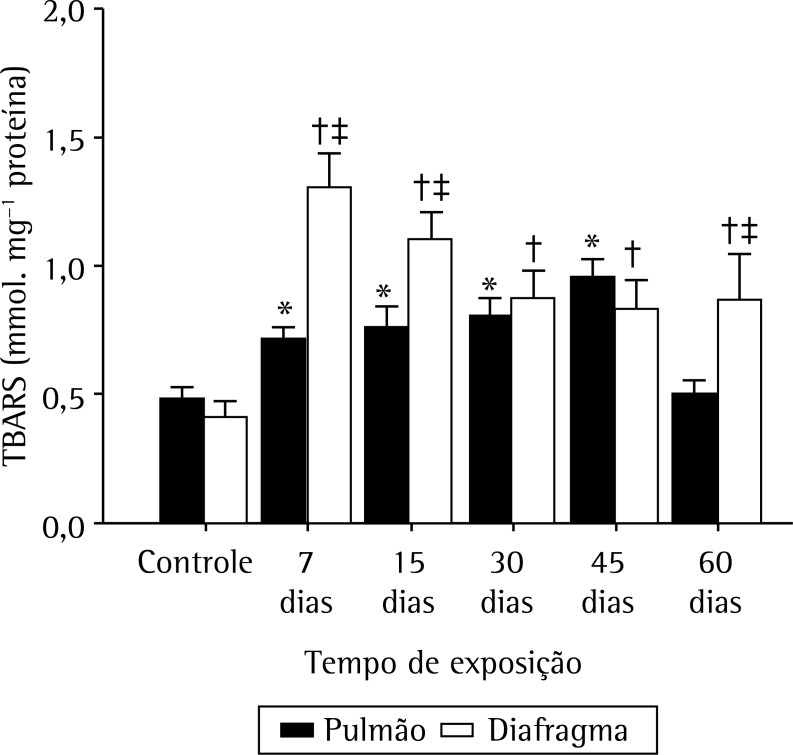
Média ± EPM dos níveis de thiobarbituric acid-reactive substances
(TBARS) no tecido pulmonar e no músculo diafragma em 6 grupos de
camundongos: grupo controle e 5 grupos expostos a fumaça de cigarro por 7,
15, 30, 45 e 60 dias, respectivamente. *p < 0,05 vs. controle no tecido
pulmonar. † p < 0,05 vs. controle no músculo diafragma. ‡ p < 0,05 vs.
tecido pulmonar.